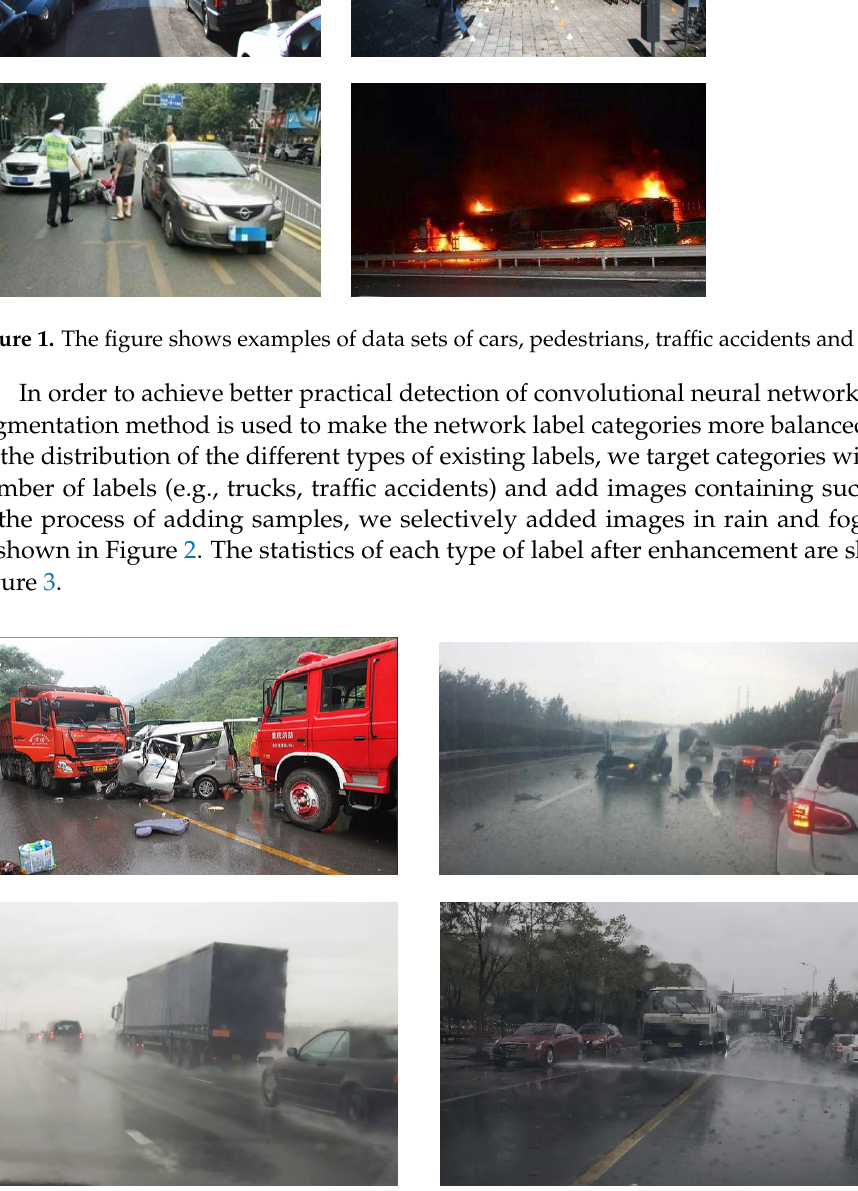
Figure 2. Example of a rainy weather image added by sample